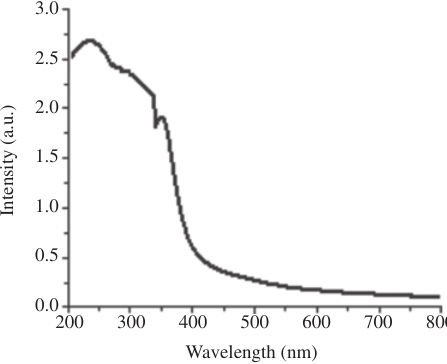
Figure 6: Ultraviolet-visible spectra of iron oxide nanoparticles.